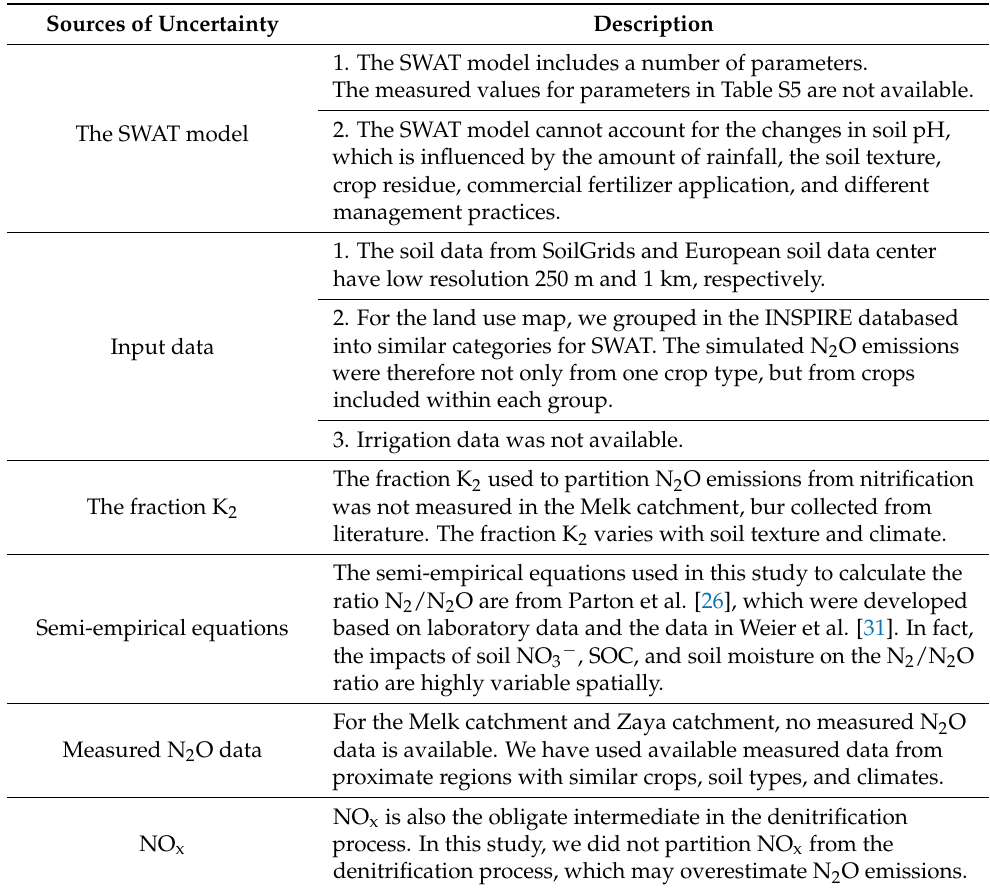
Table 7. Sources of uncertainty for simulating N 2 O emissions with the N 2 O submodule in the Melk and Zaya